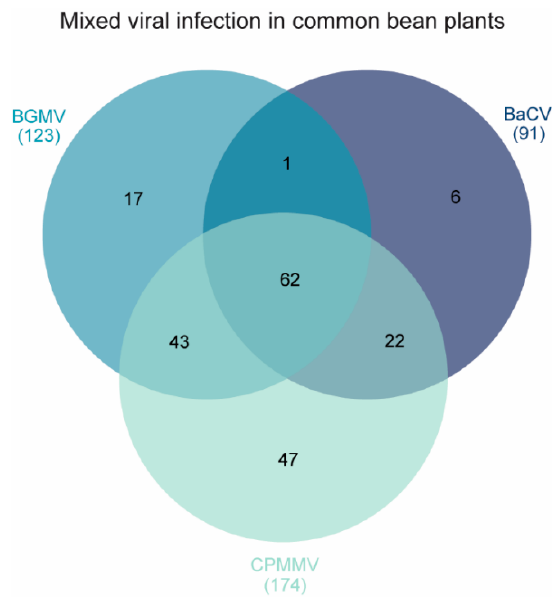
Figure 4. Distribution of viral infections in 219 common bean plants from 2007 to 2018. BaCV was found mostly in mixed infections with BGMV and CPMMV. Only six plants were found singly infected with BaCV.